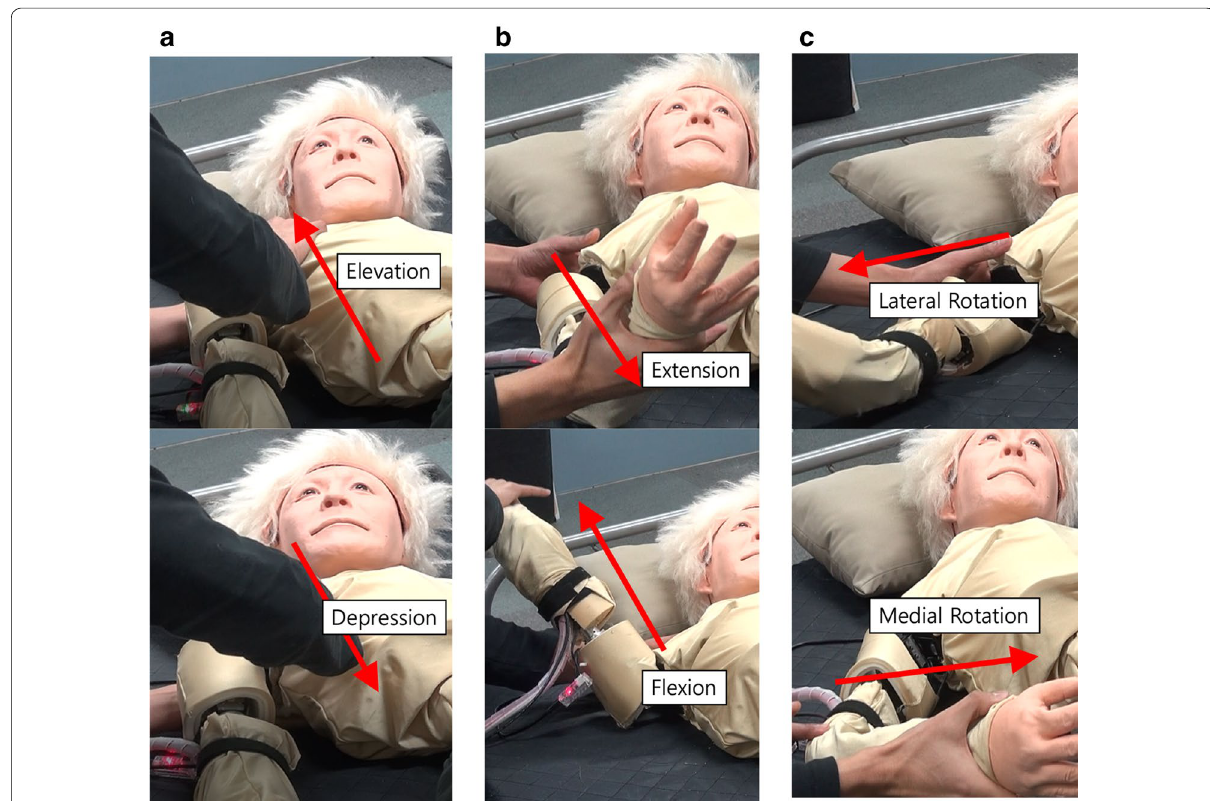
Fig. 4 Typical example of the motion range (ROM) exercise. a Elevation–depression; b extension‑flexion; c lateral rotation‑medial